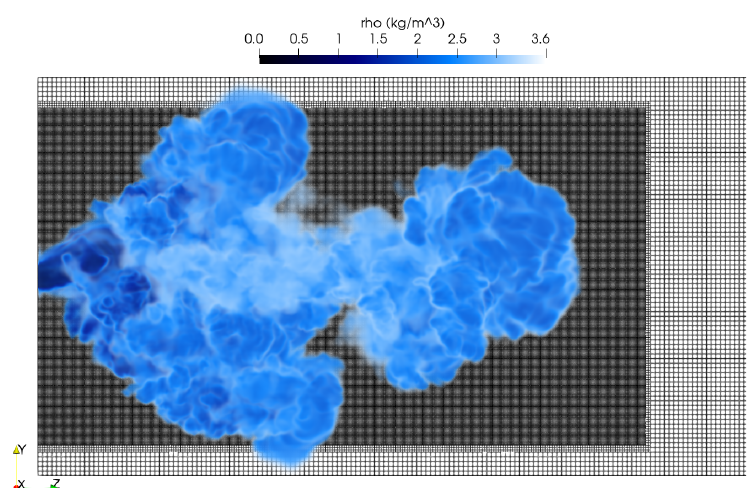
Figure 4. Schematic illustration of the computational mesh superposed with a volumetric rendering of the jet. Shown is the density field ρ